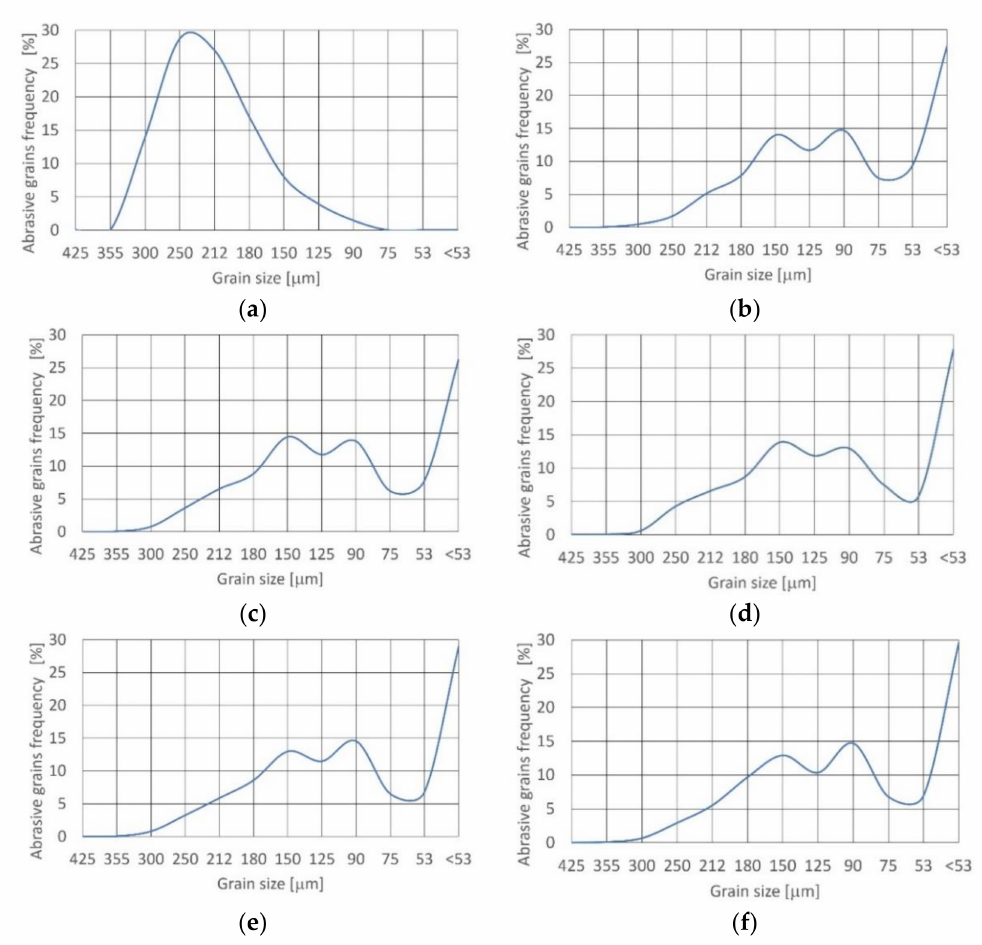
Figure 6. Size distribution of olivine grain at concentration: ( a ) fresh; ( b ) 15%; ( c ) 17.5%; ( d ) 20%; ( e ) 22.5% and ( f )